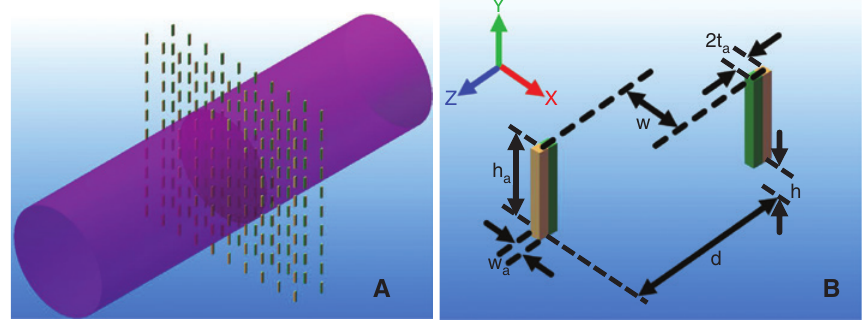
Figure 1: Schematic illustration of the designed optical system possessing the phase coupling. (A) Two counterpropagating coherent light beams are normally incident on the optical system from two sides. The purple part denotes two counterpropagating coherent light beams. (B) The structure of its unit cell. The green and yellow parts respectively indicate semiconductor and